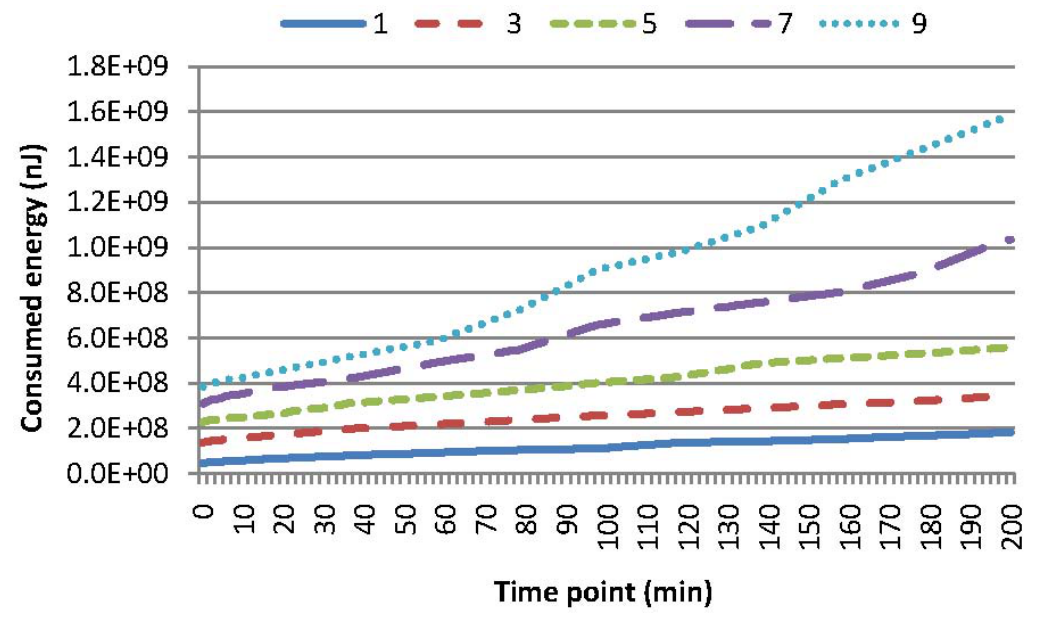
Figure 4. Comparison of the accumulated energy consumption for multi-attribute query in the whole region (MAQWR), where the number of attributes are set to 1 , 3 , 5 , 7 and 9 , respectively. The gradient of the curves represents the ratio of energy consumption for query answering. This figure shows that when the cache size in the SN is relatively small and is not capable of caching all sensory data requested by a certain query, more sensory data should be replaced in the SN according to our data replacement mechanism, as presented in Section 4.2, and more energy is required for answering the query. For instance, in comparison with the case when the number of attributes is three, 198% (or 355%) more energy is consumed for the case when the number of attributes is seven (or